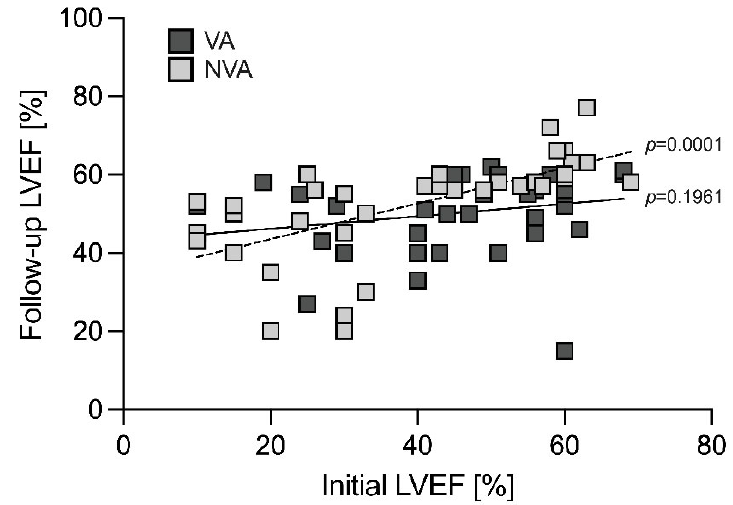
Figure 4. LVEF at baseline and during follow-up is illustrated for VA vs. NVA patients. Whereas the dashed line demonstrates a correlation between LVEF at baseline and during follow-up in the NVA group, there is no correlation in the VA group (solid line). LVEF, left ventricular ejection fraction; NVA, non-ventricular arrhythmia; VA, ventricular arrhythmia. Disease progression to DCM with LVEF ≤ 45% was seen in 10/36 (28%) VA and 9/35 (26%) NVA patients ( p = 1.0), who initially presented with a LVEF of 45 ± 4% vs. 21 ± 3% ( p < 0.001) (Table 3). Among VA patients, there was no difference in baseline LVEF between those with vs. without disease progression to DCM (45 ± 4% vs. 47 ± 5%; p = 0.446). Among NVA patients, baseline LVEF was lower in those with persistent or progressive heart failure (21 ± 2.6% vs. 46 ± 3%; p < 0.001).